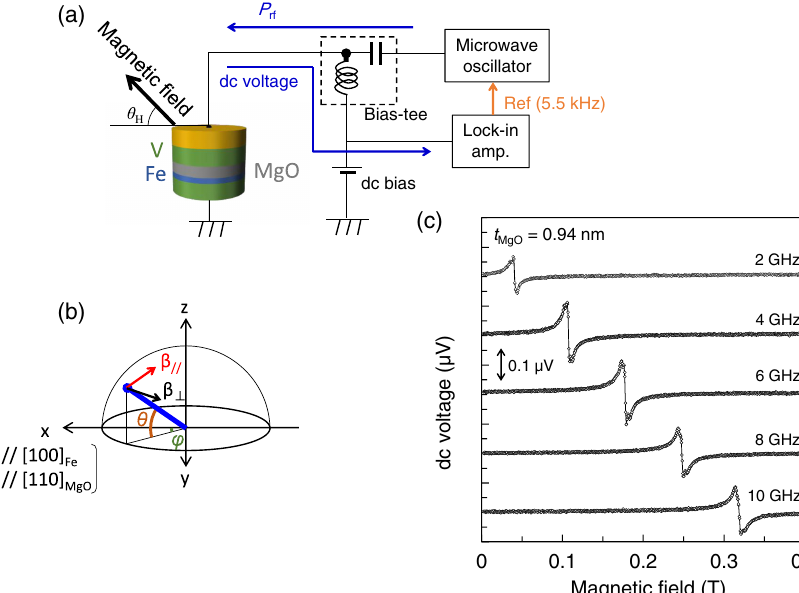
FIG. 3. (a) Schematic illustration of the measurement setup. (b) Definition of perpendicular ( β ⊥ ) and in-plane ( β == ) torque. (c) Typical spectra for spin-torque FMR. The magnetic-field direction is θ H ¼ 45 °, and the input power ( P